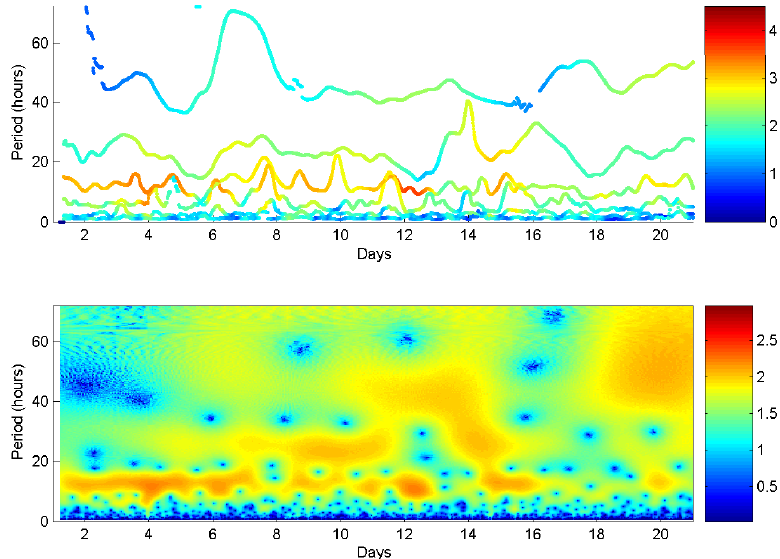
Fig. 6. A skeleton diagram of the Hilbert-Huang spectrum (a) and a contoured diagram of the continuous wavelet transform (b) applied to the time series of zonal winds observed at 90km by the Scott Base MF radar over the period 1 to 20 January 2006. wave-wave interactions. Figures 5a and b display the